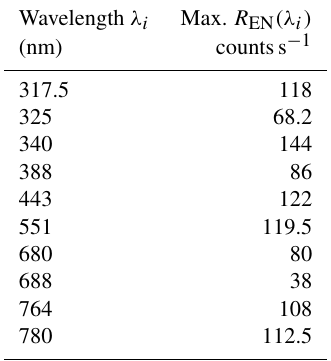
Table 2. Radiance ratio R EN (λ i ) during eclipse totality at 17:45UTC compared to 20 August.